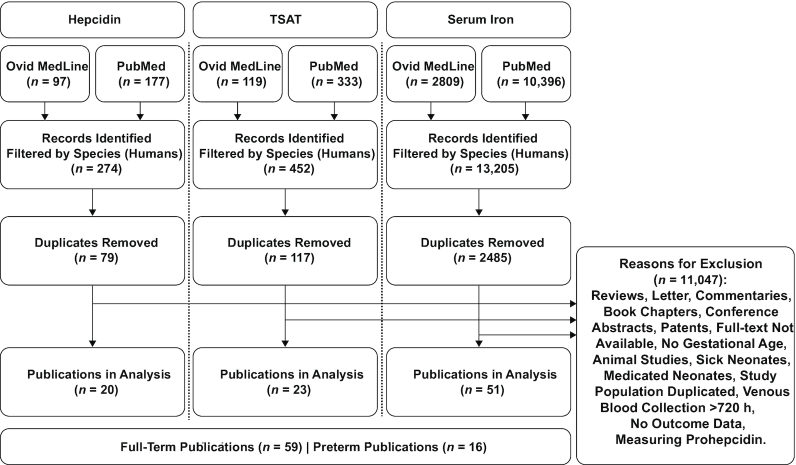
Flow diagram of the literature search and selection criteria for retrieving publications on hepcidin, TSAT, or serum iron in neonates over the first month of life. TSAT, transferrin saturation.